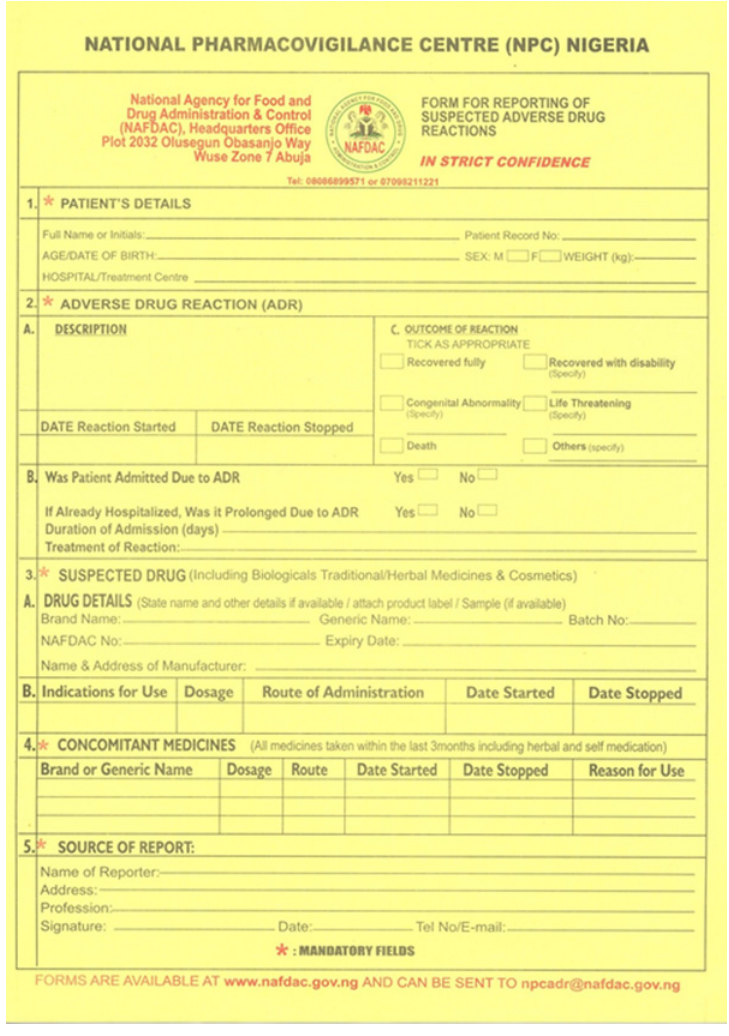
Fig 1. Pharmacovigilance Form (Yellow